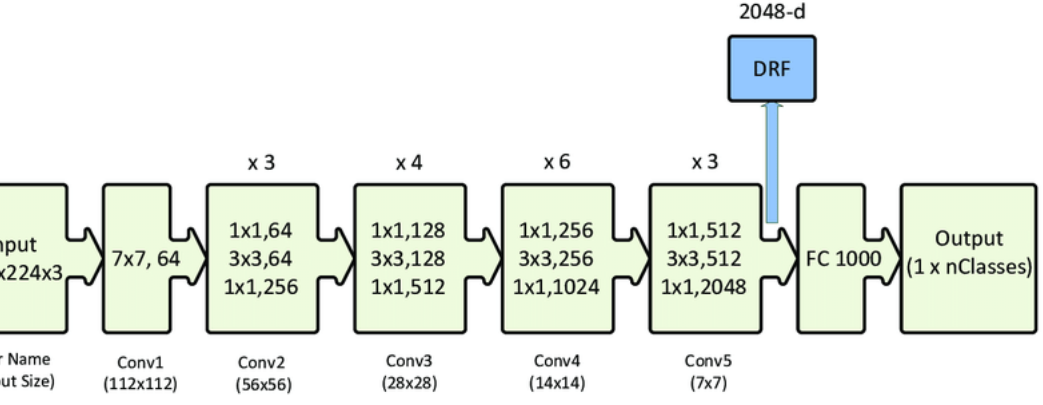
Figure 1. The architecture of the ResNet-50 model.